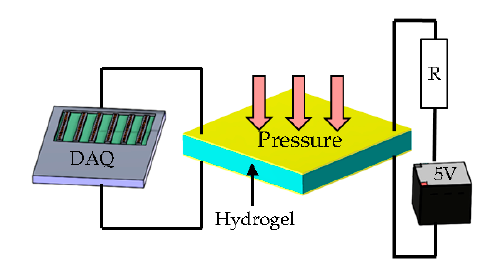
Figure 1. A schematic showing the experimental set up of hydrogel capacitive pressure